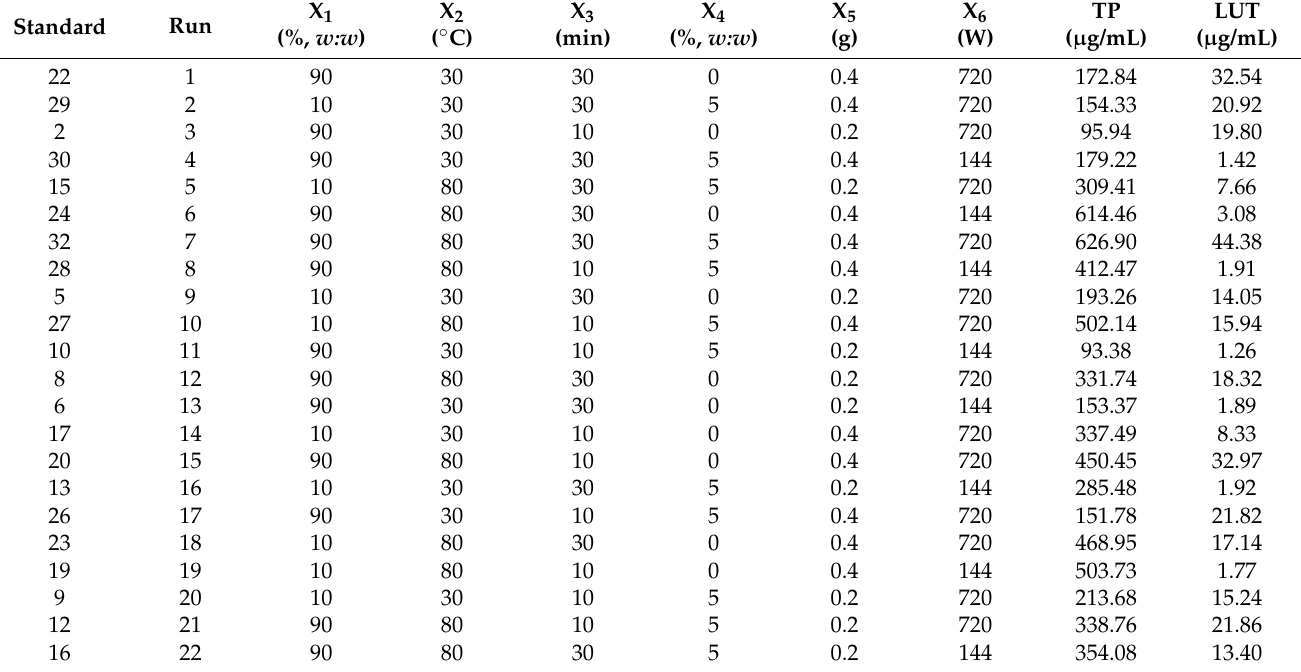
Table 1. Independent variables in the 2-Level Factorial design and content of total phenols (TP) and luteolin (LUT) in the